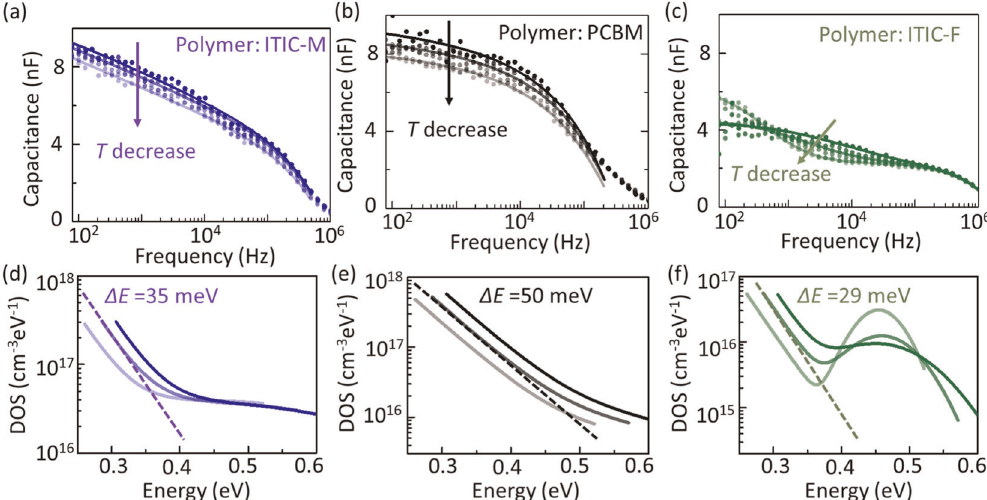
Fig. 3 Analysis of sub-bandgap density of states (DOS) via capacitance vs. frequency measurements. a – c Variable-temperature measurements of capacitance versus frequency on the organic photodiodes. Each plot has six shadings to represent data taken at different temperatures, i.e., 40, 30, 20, 10, 0, and − 6 °C. The solid lines are fi ts to determine the density of states (DOS). d – f DOS near the band edge. For the solid lines, the shading indicates the measurement temperature: dark = 40 °C; medium = 20 °C; light = − 6 °C. The dashed lines are fi ts to the exponential bandtails, and the Δ E slope is the bandtail disorder spread.